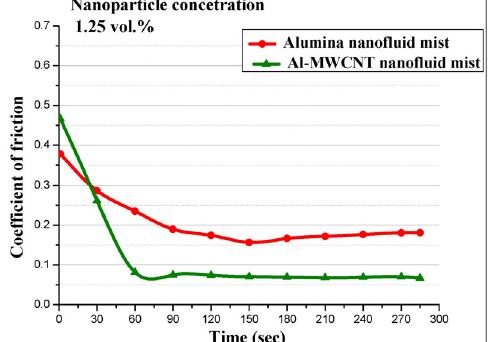
Fig. 8 Variation in coefficient of friction for alumina and Al-MWCNT hybrid nanofluid at 1.25 vol% concentration as a function of